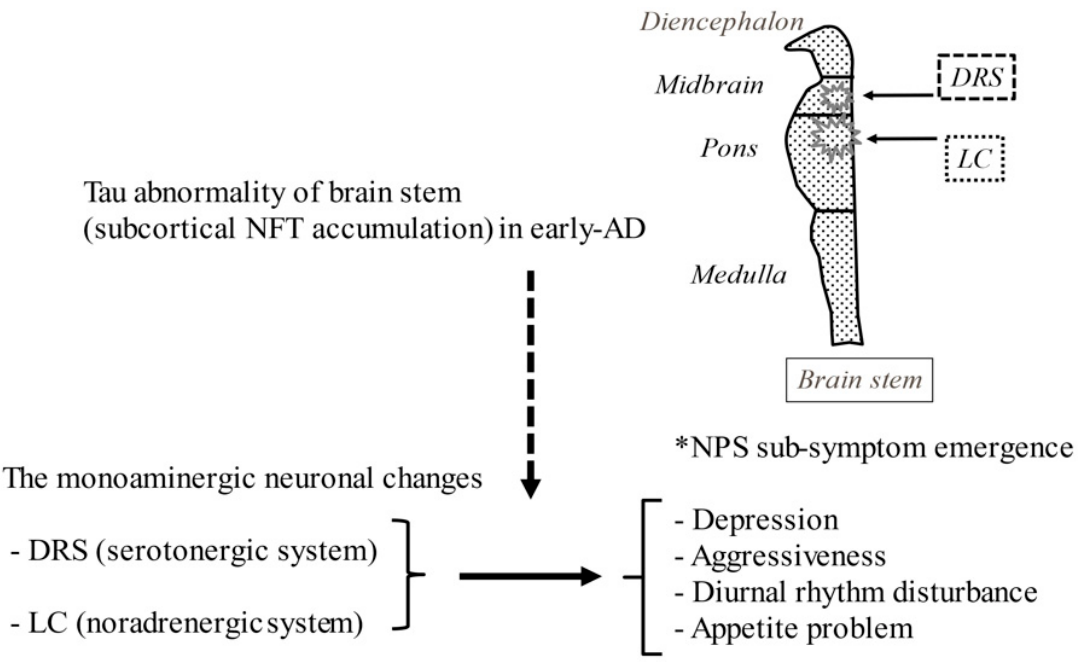
Figure 2. Some NPSs in early-AD may originate from the involvement of monoaminergic neurons, including the serotonergic DRS and the noradrenergic LC. This might be relevant to early tau pro- tein abnormalities, suggesting subcortical NFT accumulation. Abbreviations: AD: Alzheimer’s Dis- ease, DRS: dorsal raphe nucleus, LC: locus coeruleus, NFT: neurofibrillary tangle, NPS: neuropsy- chiatric symptom.